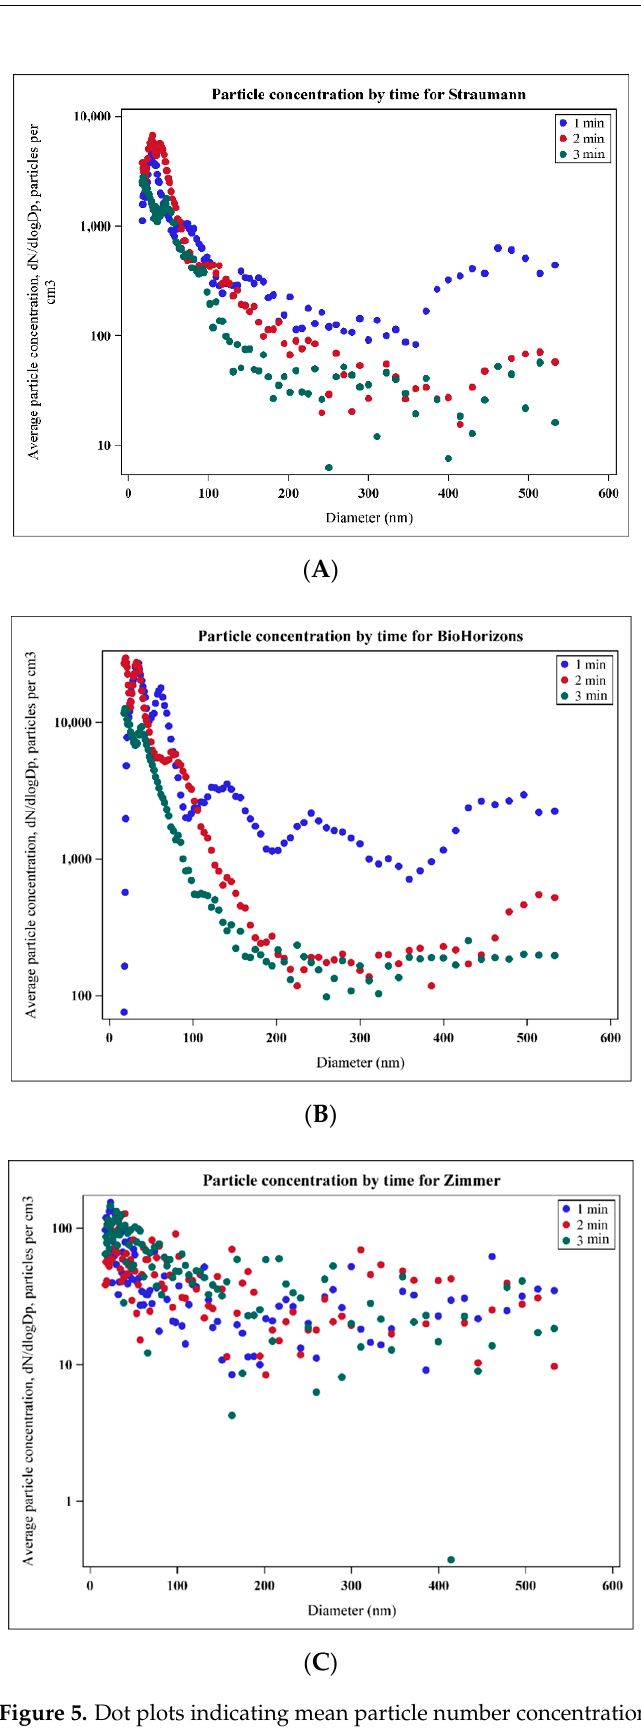
Figure 5. Dot plots indicating mean particle number concentration stratified by minute for ( A ) Strau- mann; ( B ) BioHorizons; ( C ) Zimmer.